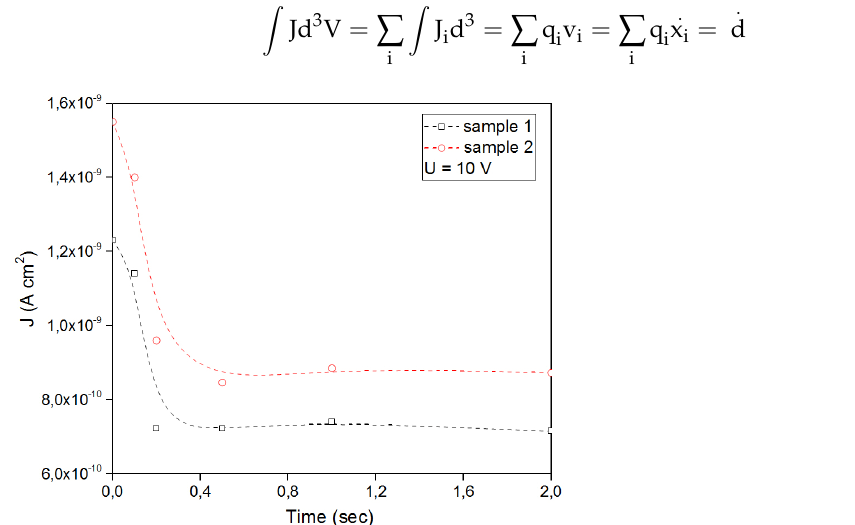
Figure 9. Dependence of the current density at 10 V applied voltage at different measurement frequencies on t = 0.01 ÷ 2 s.